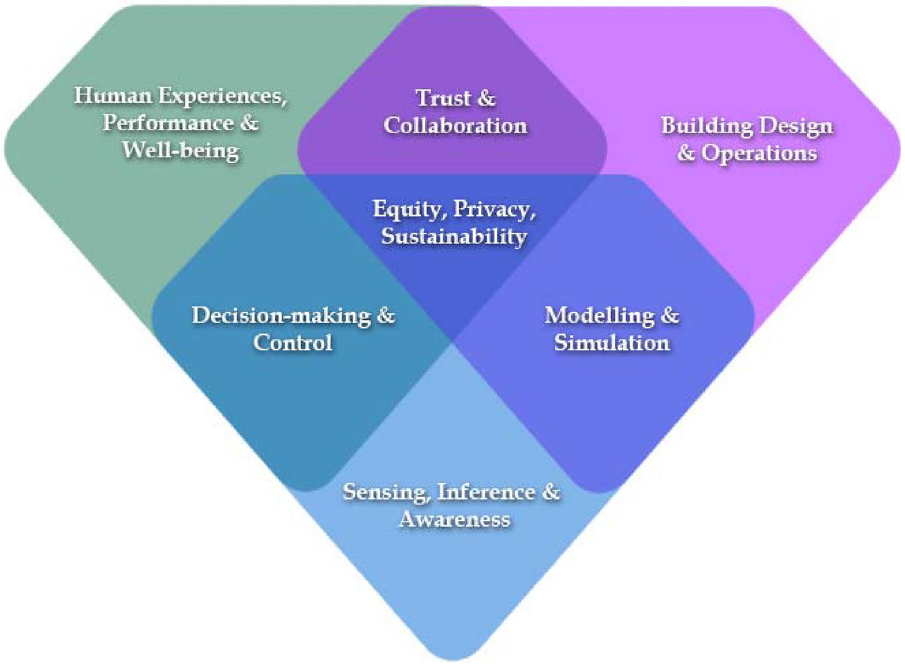
Figure 1. Primary HBI research areas, intersecting interdisciplinary research domains, and core principles of all HBI research. Image credit: Basma